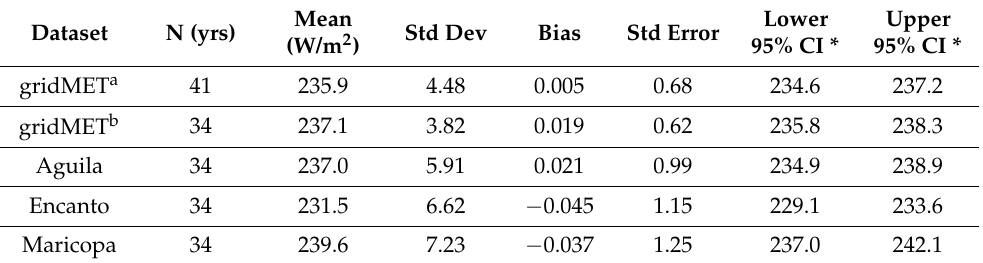
Table 7. Descriptive statistics of annual data with bootstrapping (N = 1000). * CI =